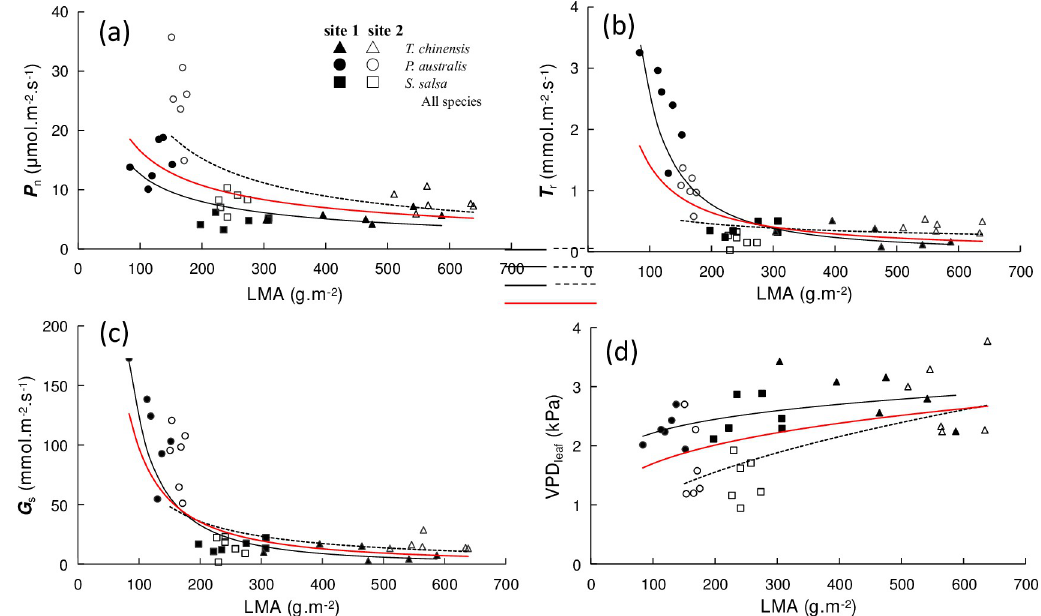
Fig 3. Relationships between LMA and gas exchange characteristics of halophytic plant communities. (a) LMA and P n (equation for site 1: y = 255.59x − 0.654 , R 2 = 0.489, P = 0.001; equation for site 2: y = 935.77x − 0.777 , R 2 = 0.481, P = 0.001; equation for all species: y = 295.94x − 0.626 , R 2 = 0.321, P < 0.001); (b) LMA and T r (equation for site 1: y = 7037x − 1.721 , R 2 = 0.792, P < 0.001; equation for site 2: y = 3.8727x − 0.403 , R 2 = 0.053, P = 0.358; equation for all species: y = 268.35x − 1.139 , R 2 = 0.375, P < 0.001); (c) LMA and G s (equation for site 1: y = 729930x − 1.89 , R 2 = 0.804, P < 0.001; equation for site 2: y = 9216.9x − 1.048 , R 2 = 0.270, P = 0.027; equation for all species: y = 80893x − 1.46 , R 2 = 0.511, P < 0.001); (d) LMA and VPD leaf (equation for site 1: y = 1.1491x 0.1426 , R 2 = 0.272, P = 0.026; equation for site 2: y = 0.1273x 0.4721 , R 2 = 0.397, P = 0.005; equation for all species: y = 0.5527x 0.2437 , R 2 = 0.160, P =